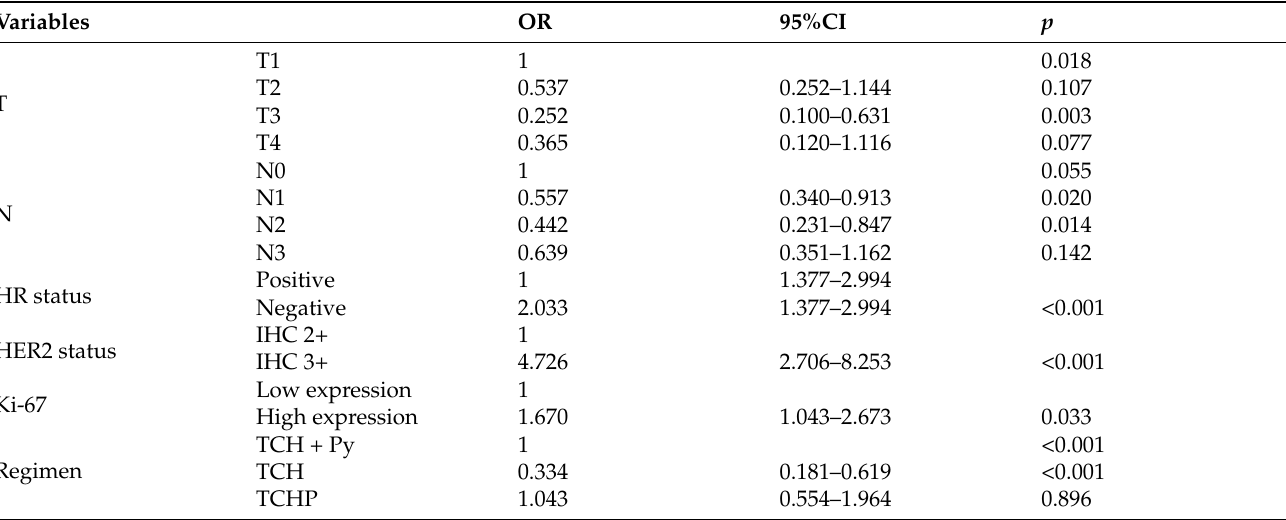
Table 3. Multivariate analysis of factors associated with pCR.